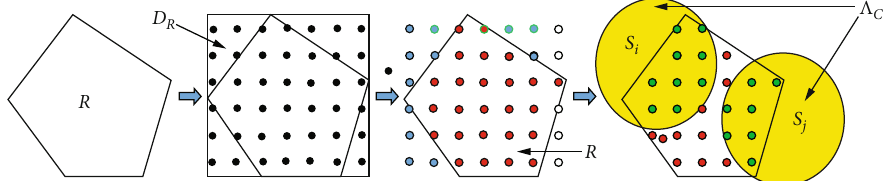
Figure 1: Basic steps of the net point